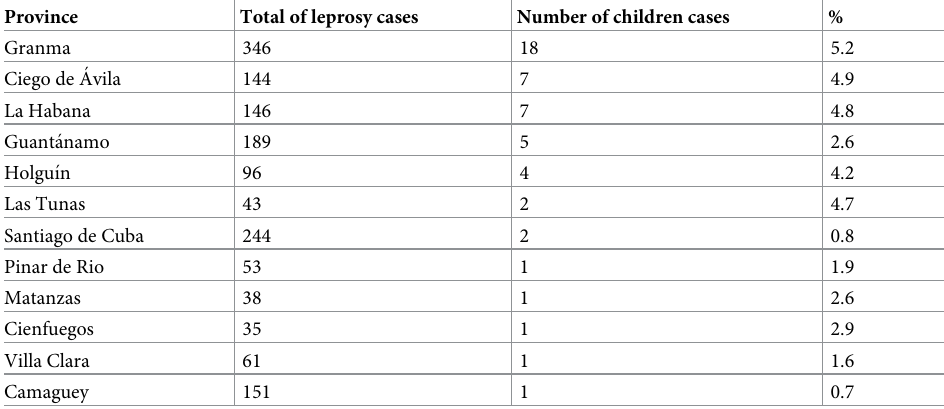
Table 3. Detection of leprosy cases in adults and children by province. Cuba 2012–2019.